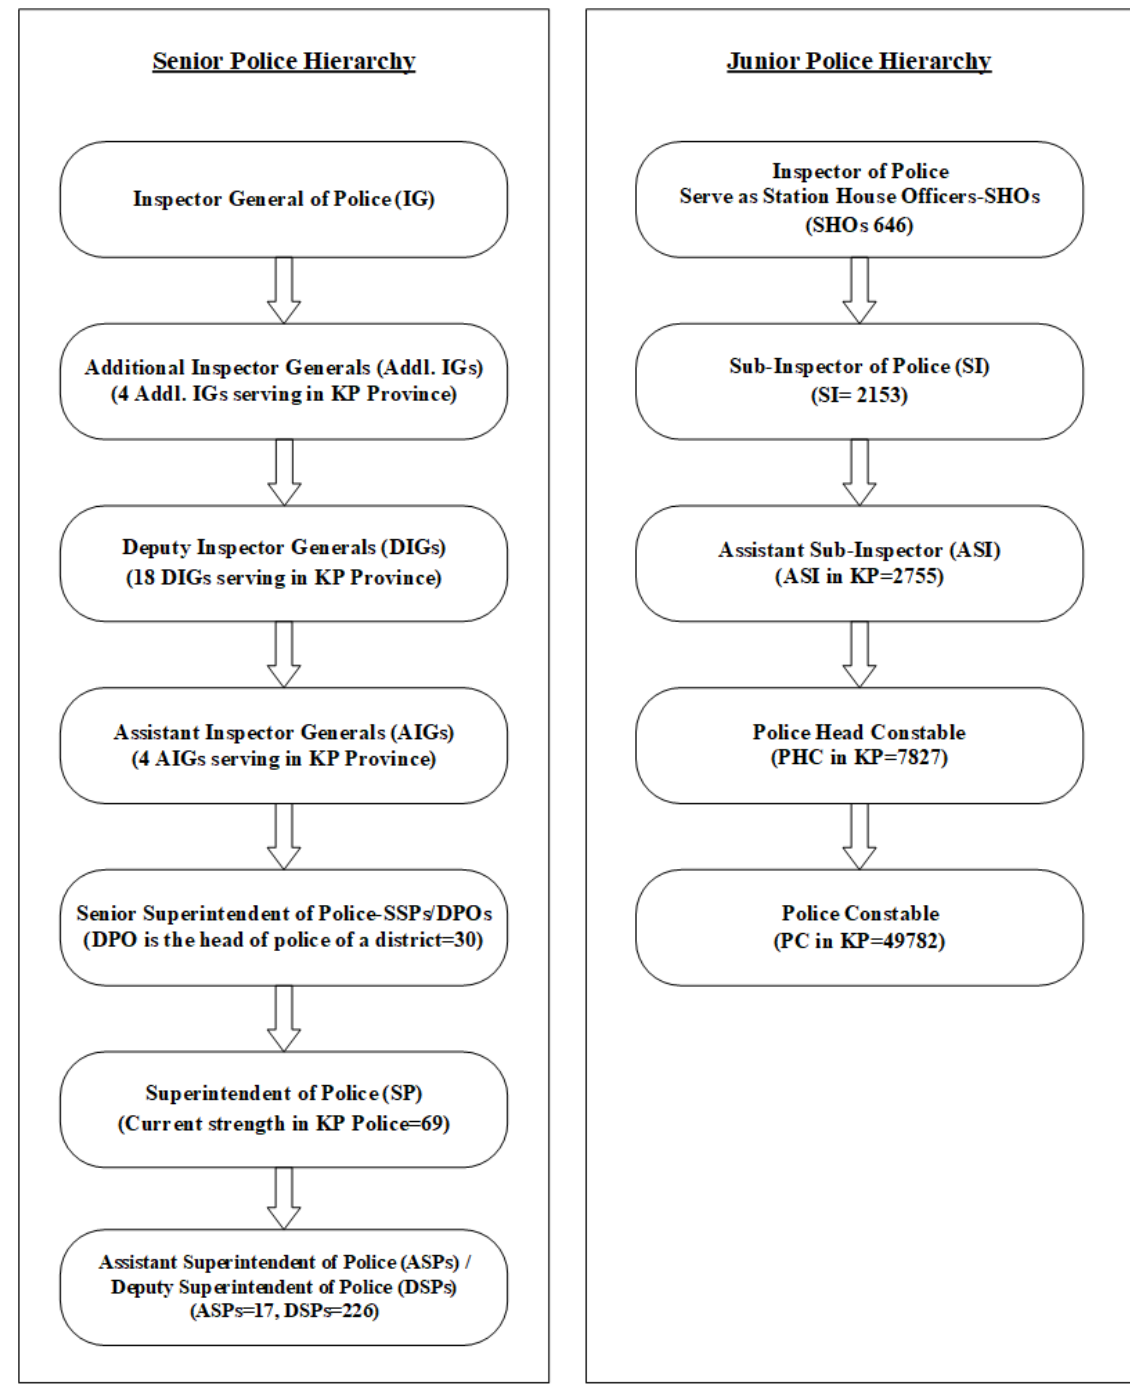
Figure 1. Police Hierarchy in